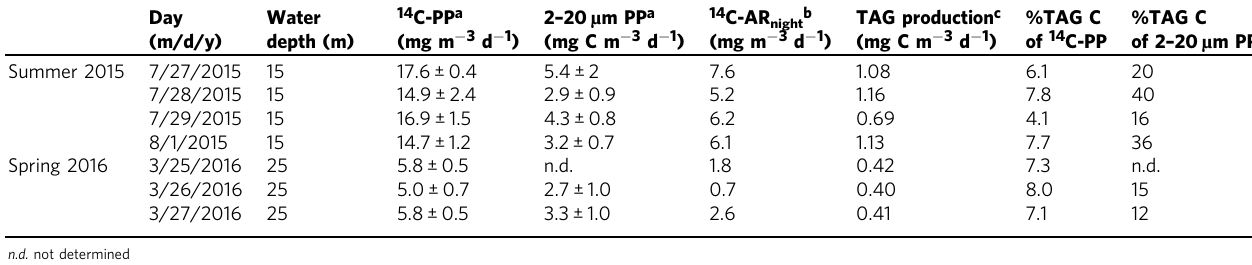
Table 2 Triacylglycerol (TAG) production rates and their contribution to overall daytime net primary production (PP) Day Water (m/d/y) depth